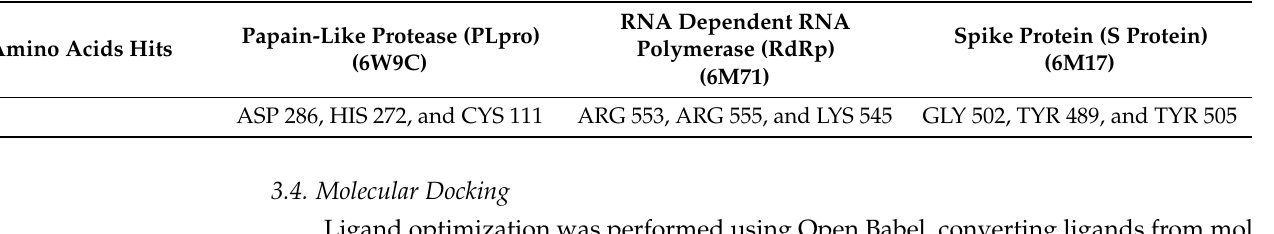
Table 4. Protein target amino acids for molecular docking.